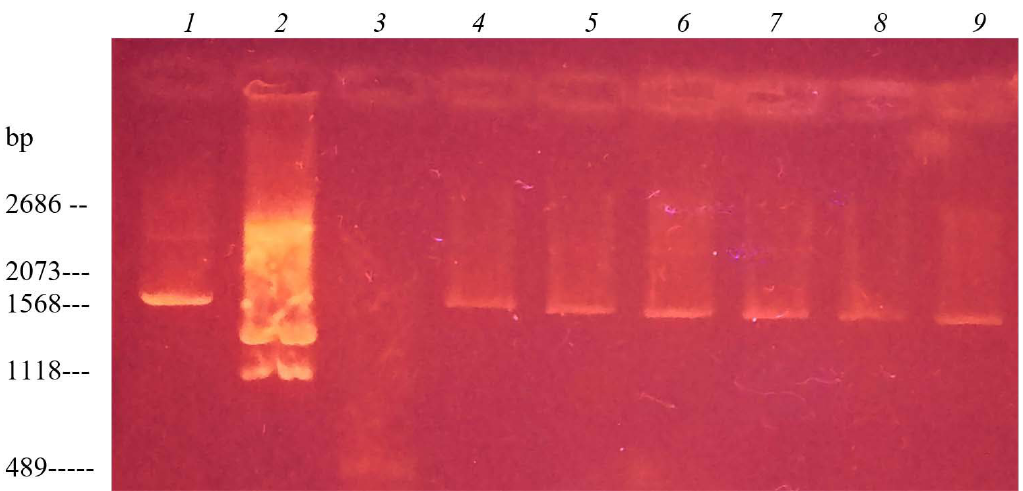
Fig. 3. Electrophoregram of DNA markers and isolated DNA plasmid by Birnboim-Dolis’ alkaline lysis method from E. coli field isolates: 1 - plasmid marker pUC19, digested with the enzyme Mva I (2686, 2073 BP); 2 - plasmid marker pUC19, digested with the enzyme Bgl I (1568, 1118 BP); 3 - plasmid marker pUC19, digested with the enzyme Msp I (489 BP); 4 - E. coli 1/44; 5 - E. coli 7/80; 6 - E. coli 9/97; 7 - E. coli 10/98; 8 - E. coli 12/100; 9 - E. coli